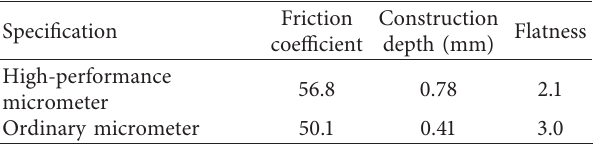
Table 5: Field test results of the